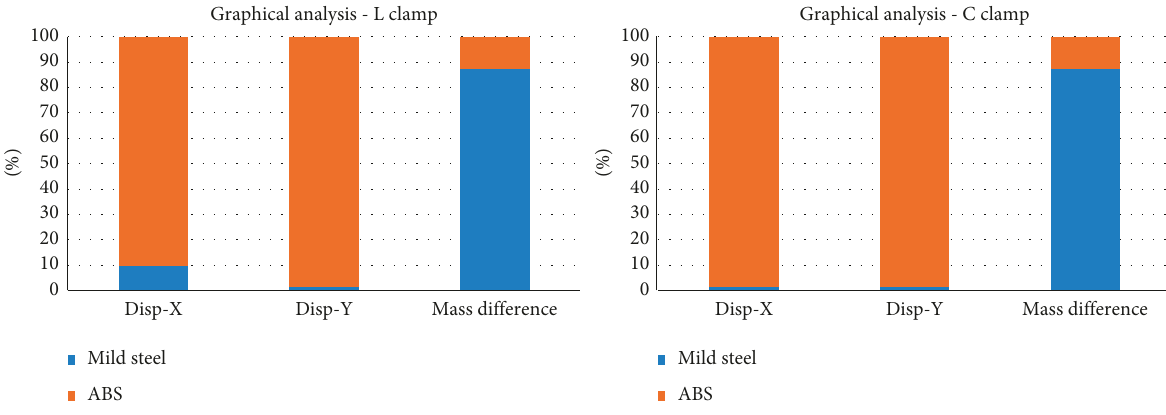
Figure 13: Graphical proportion: topology optimized compliant materials vs mild